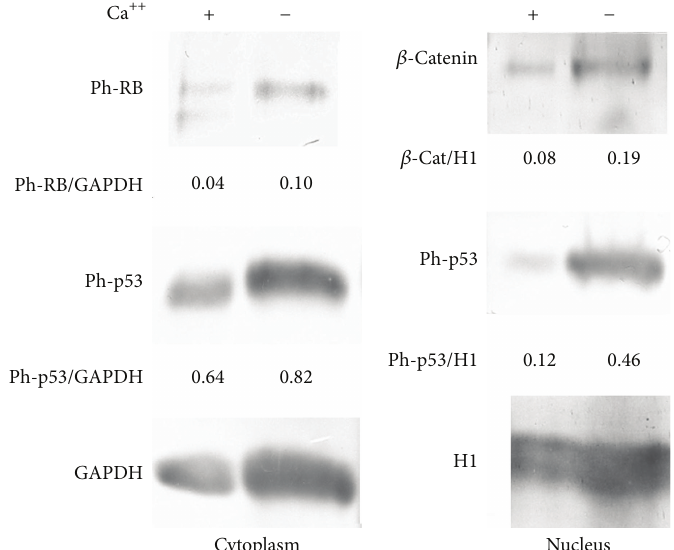
Figure 8: Growth of wild type podocytes in Ca 2+ -free medium induced the same effects of nephrin ablation on 𝛽 -catenin, p53, and phospho- pRB expressions and distribution. The cells were lysated, fractionated, and processed for western blot as described in Section 2. The antibodies used have been described in the previous figures. To quantify the protein bands, we scanned the blots and performed a densitometry analysis, using the software NIH ImageJ v. 6.4 (freeware, NIH, MD, USA). The figure shows a typical experiment of at least three performed under the same